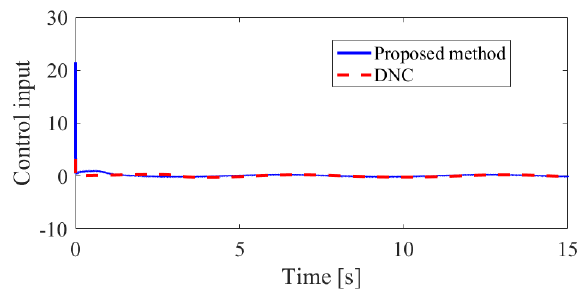
Figure 11. The control input in Case